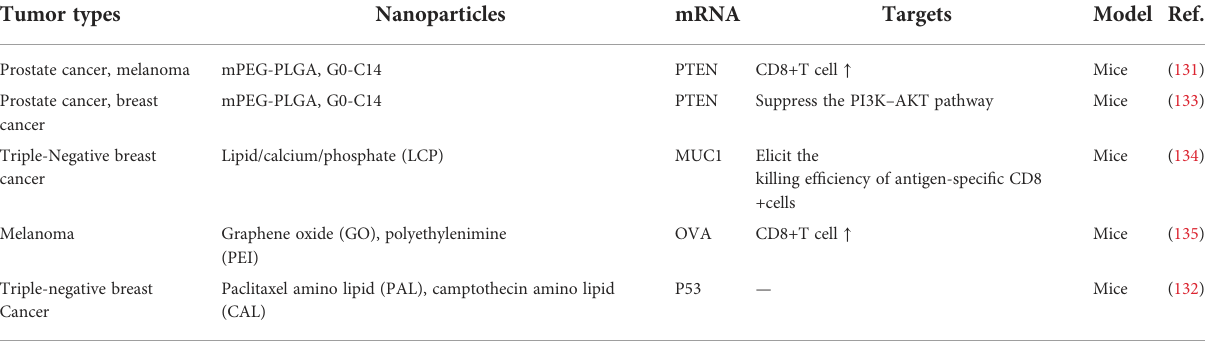
TABLE 3 LNP-based mRNA vaccines in translational